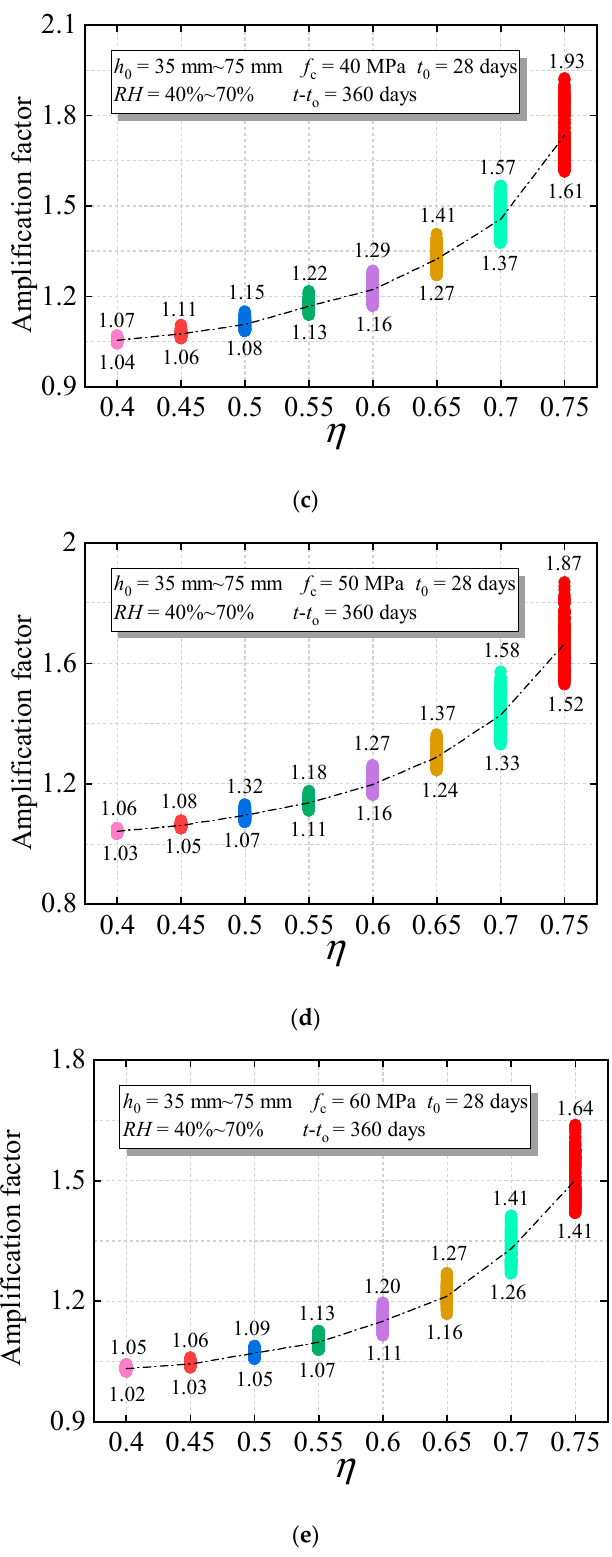
Figure 6. Confidence interval of nonlinear creep amplification coefficient: ( a ) amplification factor (20 MPa); ( b ) amplification factor (30 MPa); ( c ) amplification factor (40 MPa); ( d ) amplification factor (50 MPa); ( e ) amplification factor (60 MPa).